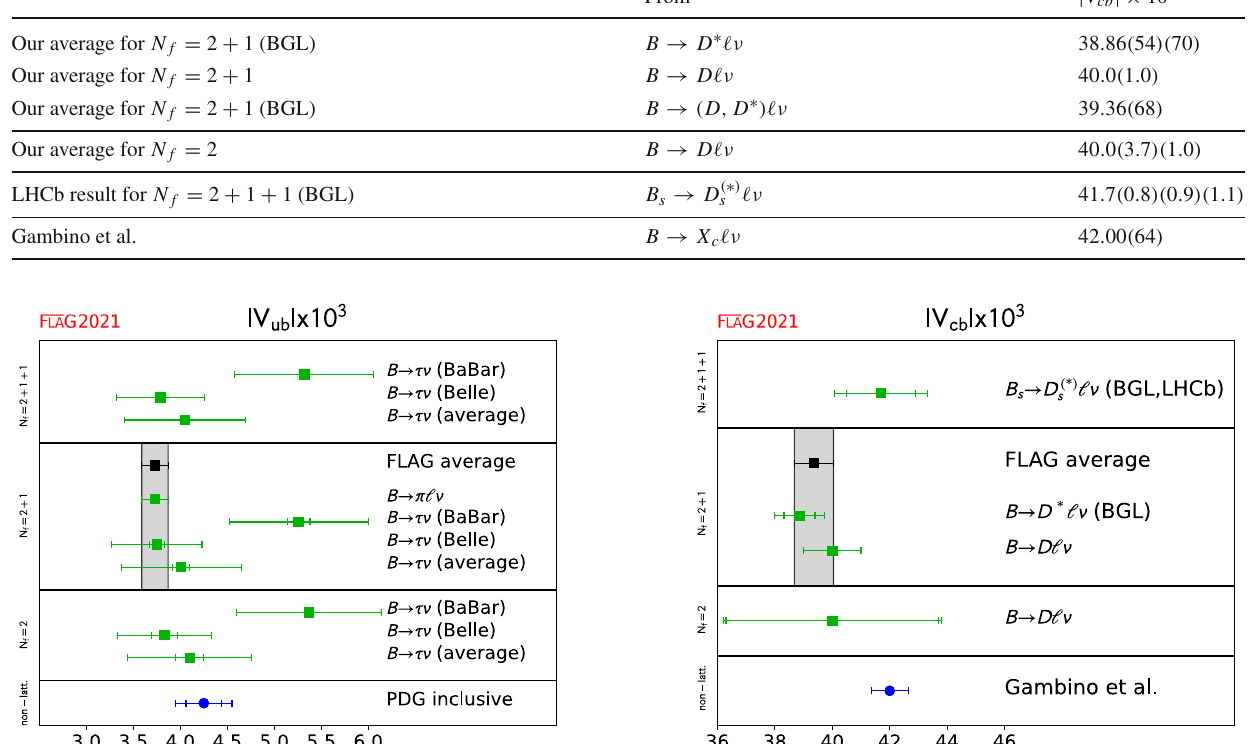
Fig. 37 Left: Summary of | V ub | determined using: i) the B -meson leptonic decay branching fraction, B ( B − → τ − ¯ ν) , measured at the Belle and BaBar experiments, and our averages for f B from lattice QCD; and ii) the various measurements of the B → π(cid:6)ν decay rates by Belle and BaBar, and our averages for lattice determinations of the relevant vector form factor f + ( q 2 ) . Right: Same for determinations of | V cb | using semileptonic decays. The inclusive results are taken from Refs.